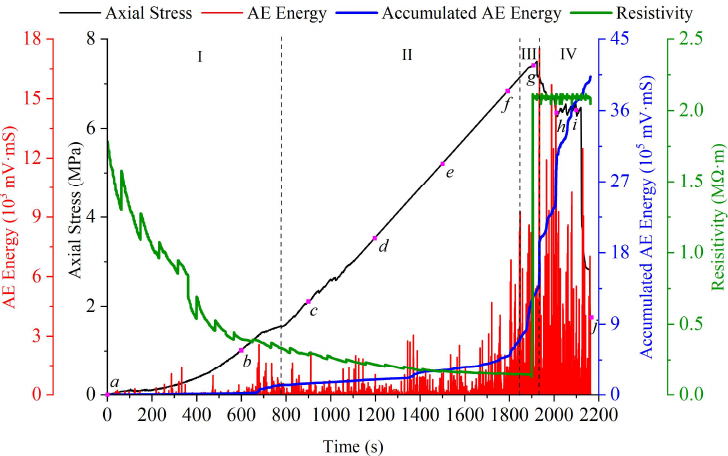
Figure 5. Response of axial stress, AE energy, accumulated AE energy, electrical resistivity for serial